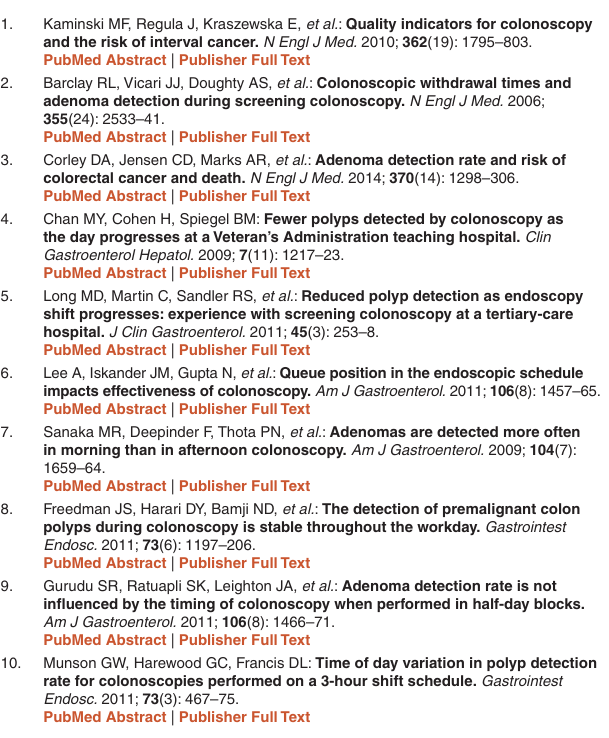
figshare: Dataset showing all procedures included in analysis of polyp detection study, http://dx.doi.org/10.6084/m9.figshare.1016982